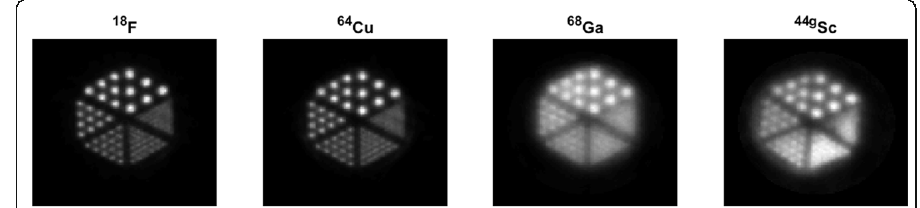
Fig. 5 Derenzo phantom image reconstructed with OSEM2D for different radionuclides